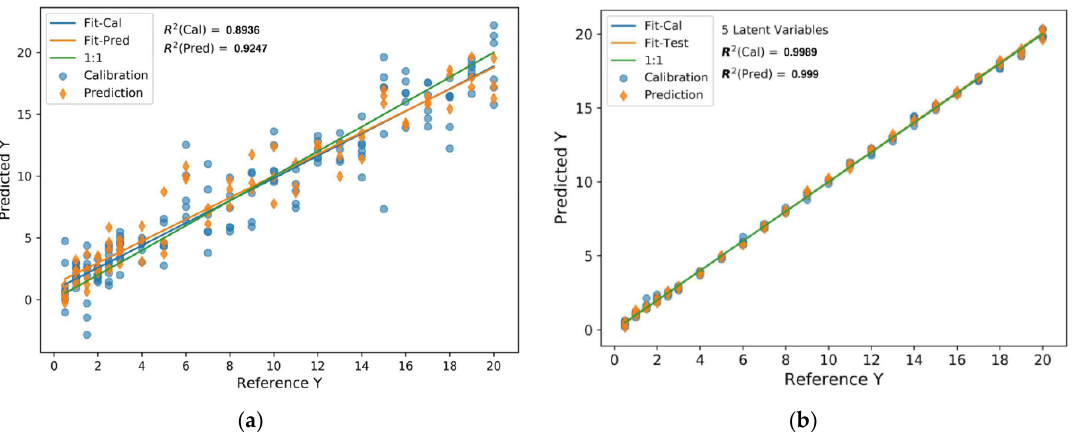
Figure 8. ( a ) Performance of the multiple linear regression (MLR) model in spray-dried porcine plasma (SDPP) concentration prediction based on the electronic nose data; ( b ) performance of the partial least squares regression (PLSR) model in SDPP concentration prediction based on the NIRS data.